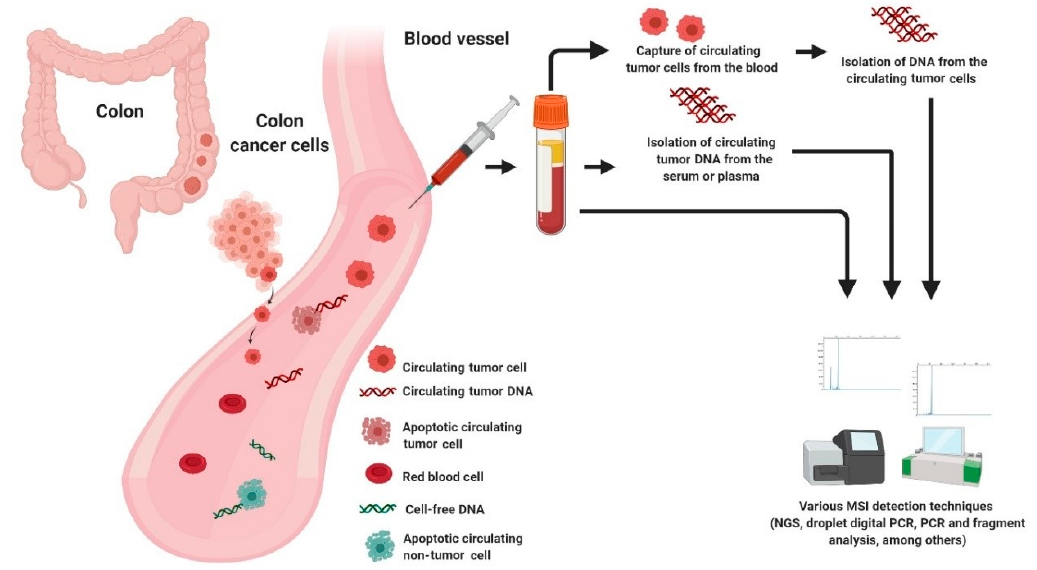
Figure 2. Possible sources of DNA for MSI testing in liquid biopsy.